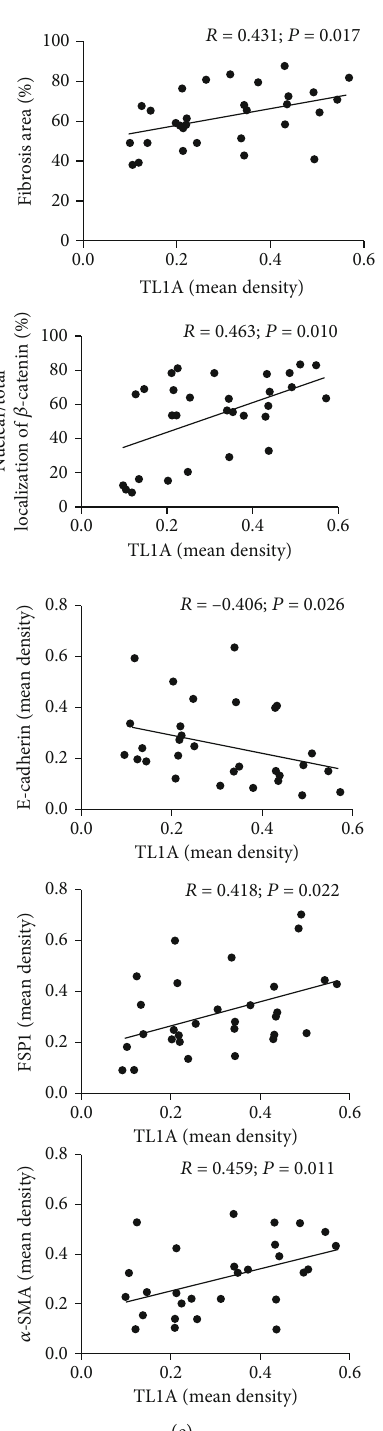
Figure 1: TL1A in colon tissue of patients with ulcerative colitis (UC) and Crohn ’ s disease (CD) correlates with fi brosis score and EMT- related markers. Colon tissues from CD patients ( n = 10 ), UC patients ( n = 12 ), and controls ( n = 8 ) were included. (a, b) Representative microscopic images of hematoxylin and eosin- (H&E-) stained para ffi n-embedded colonic tissue samples (100x), and the quantitative determination of fi brosis area based on Sirius red staining (100x). (c) Immuno fl uorescence double staining. E-cadherin (green), α -SMA (red), and colocalization (yellow) in colon tissue samples of IBD patients and controls (400x). DAPI stains nuclei (blue). (d) Immunohistochemical staining of β -catenin, TL1A, E-cadherin, FSP1, and α -SMA in colon tissues of controls and IBD patients (400x), and mean density of nuclear localization of β -catenin and expressions of TL1A, FSP1, and α -SMA were increased in the UC and CD groups; however, the mean density of E-cadherin was decreased in the UC and CD groups. (e) Pearson ’ s correlation and linear analysis. Data were given as mean ± standard deviation (SD). As compared to the control group: ∗ P < 0 : 05 , ∗∗ P ≤ 0 : 01 , and ∗∗∗ P ≤ 0 : 001